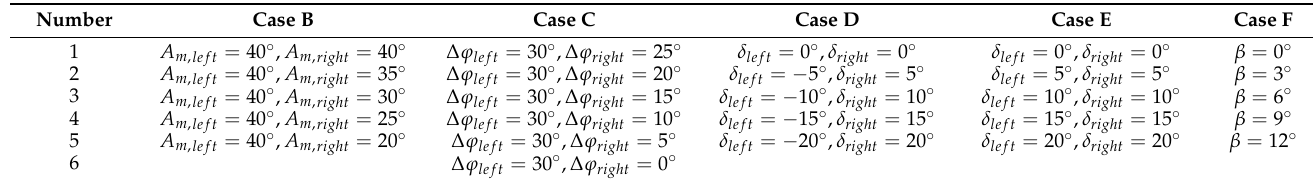
Table 4. Pectoral fin oscillating motion parameters for Cases B, C, D, E, and F. Case D Case E Case F